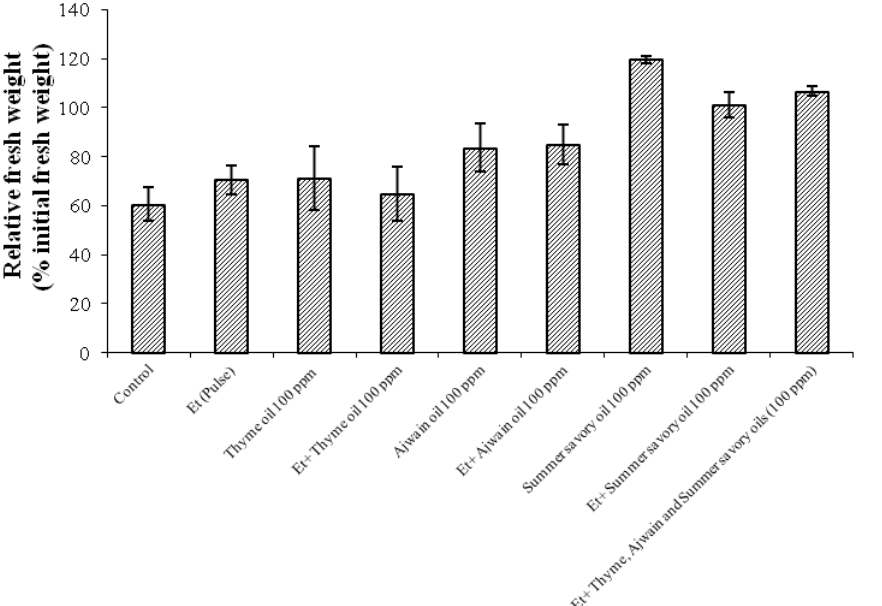
Fig. 5. Effect of pulse Et and 100 ppm concentration of different essential oils alone and in com- bination treatment on relative fresh weight of carnation cut flowers (cv. ‘Yellow Candy’)